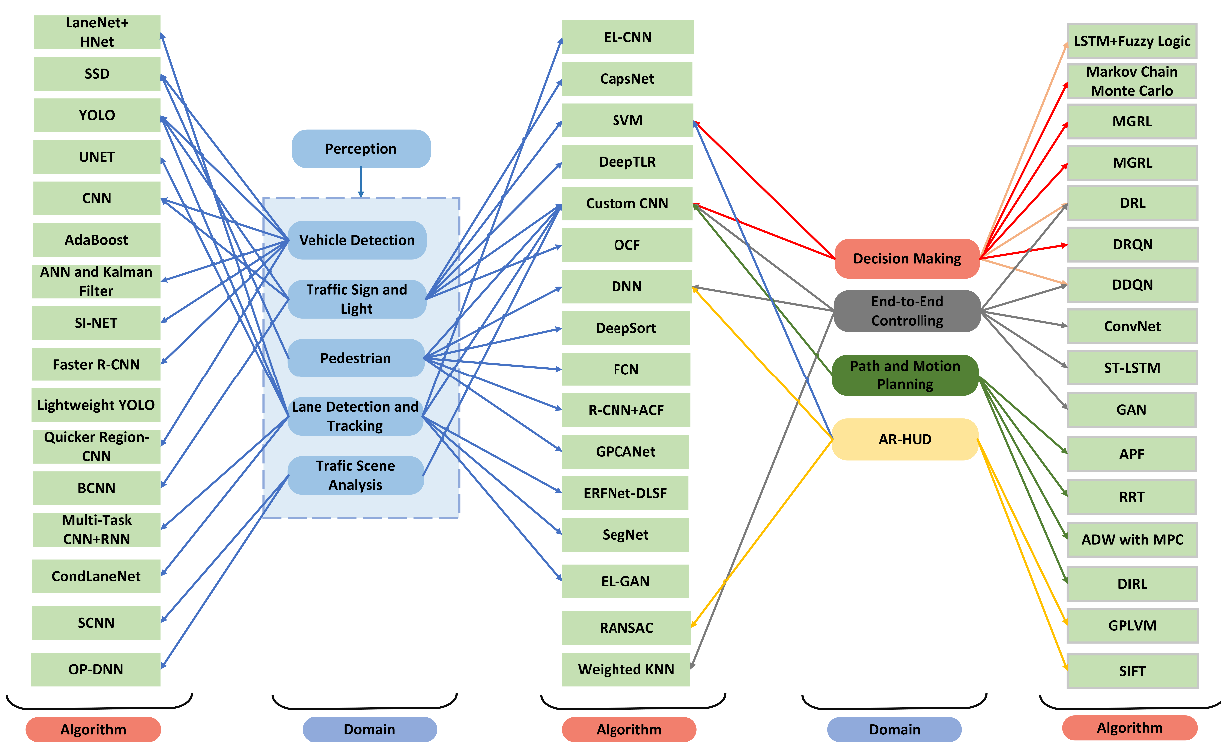
Figure 4. Taxonomy algorithms for each domain.